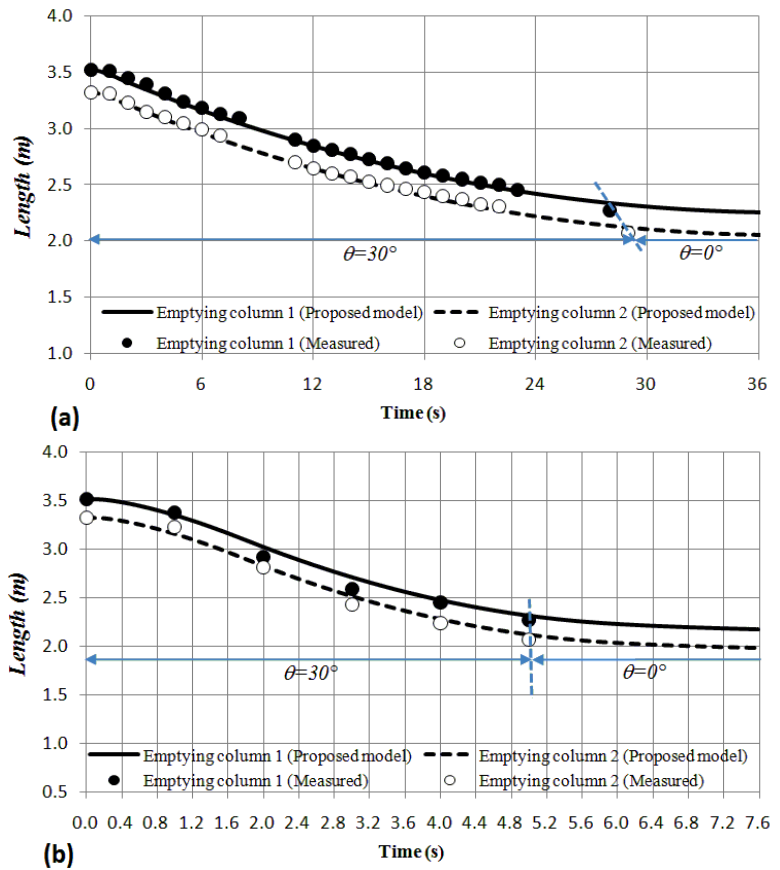
Figure 7. Comparison between computed and measured length of emptying columns: ( a ) Test No. 2 (air valve S 050); ( b ) Test No. 7 (air valve D